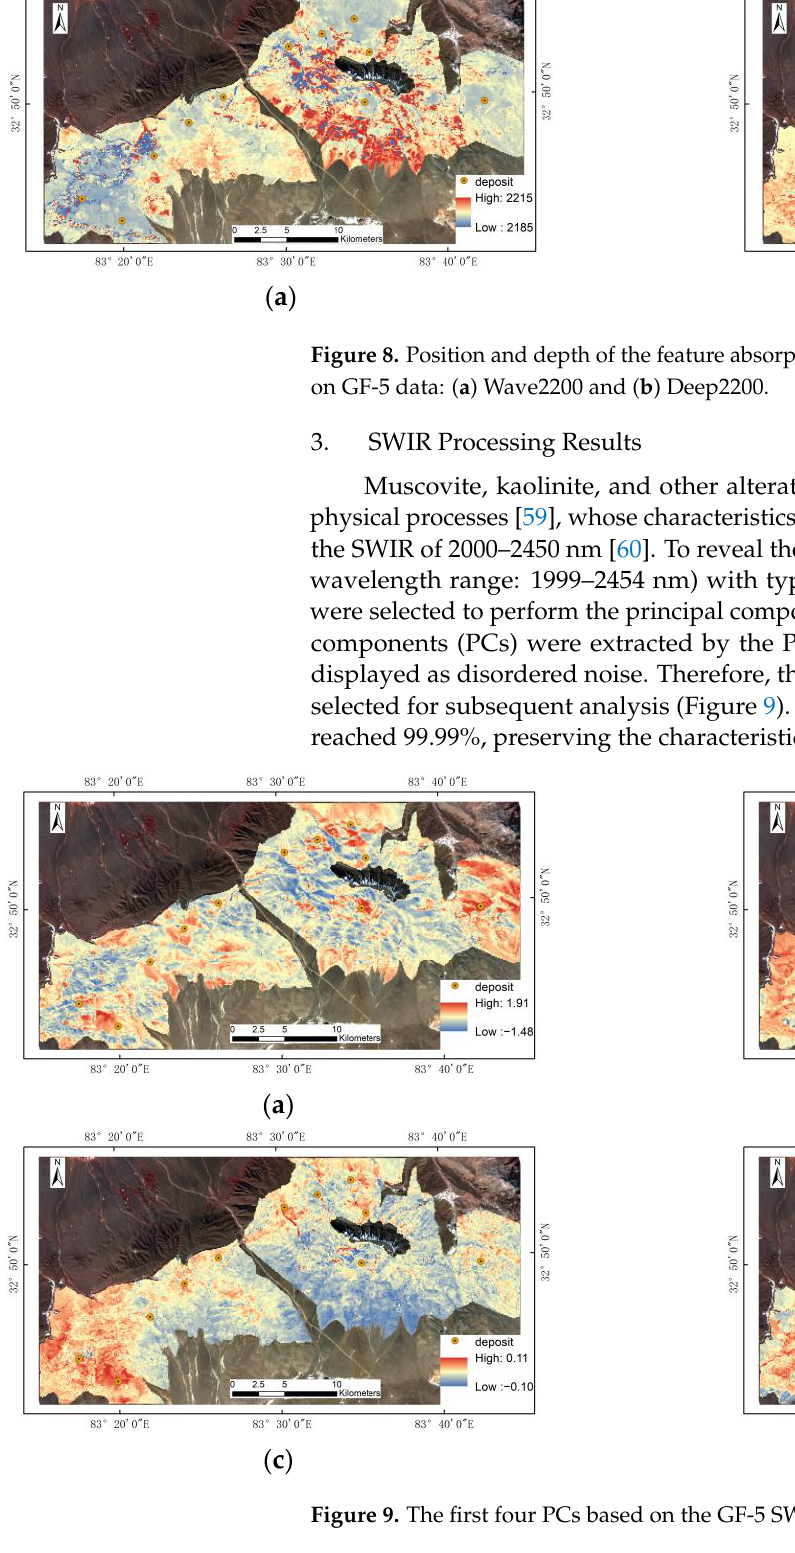
olong. The distributions of the other three alteration minerals extracted from ASTER data are similar to those from GF-5 HSIs. There is obvious local enrichment of muscovite, such